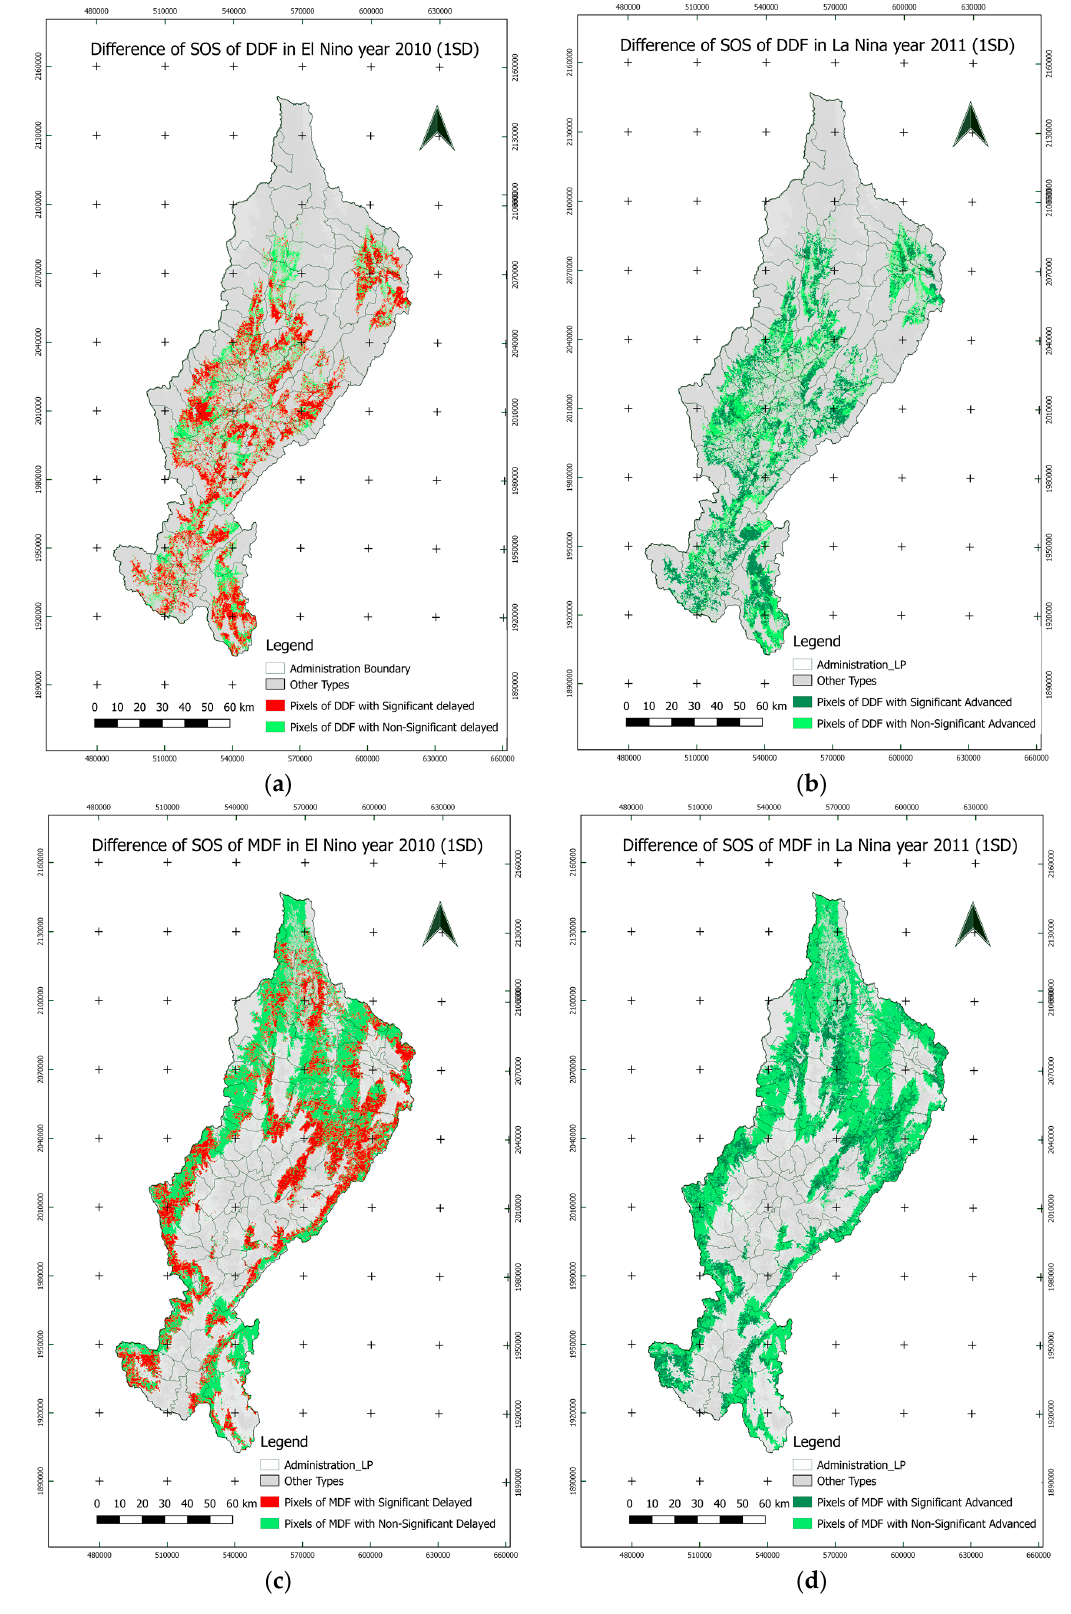
Figure 12. The spatial difference of SOS DDF and SOS MDF between El Niño ( a , c ) and La Niña ( b , d ) respectively, compared to that of the neutral year. The significant difference is based on 1SD.